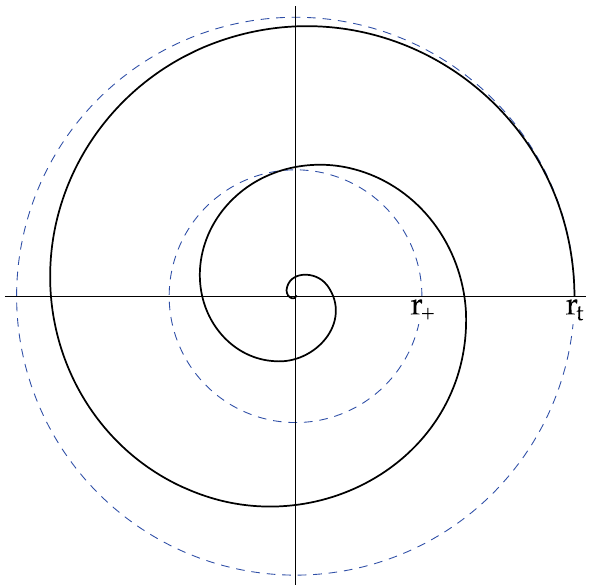
Fig. 4 Polar plot for a confined trajectory of photons from a distance r t